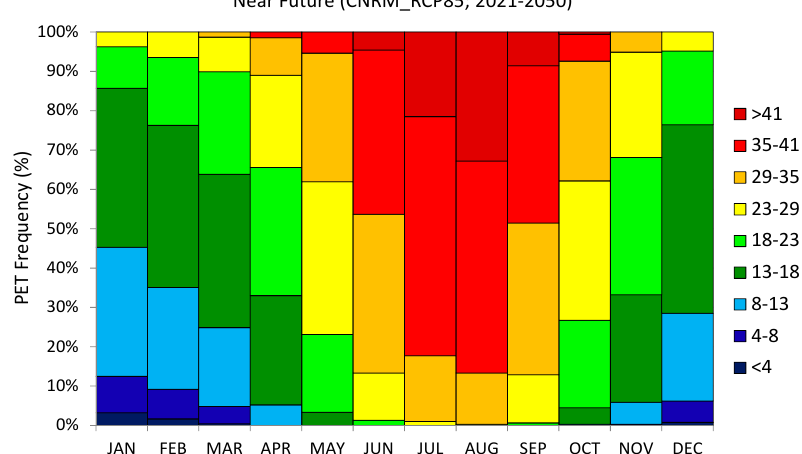
Figure 3. Bioclimate diagram for Milos Island, indicating PET frequency (%) per month, for the near future 2021–2050, based on Centre National de Recherche Meteorologiques (CNRM) regional climate model for two Representative Concentration Pathways (RCPs), RCP4.5 (upper graph) and RCP8.5 (lower graph).